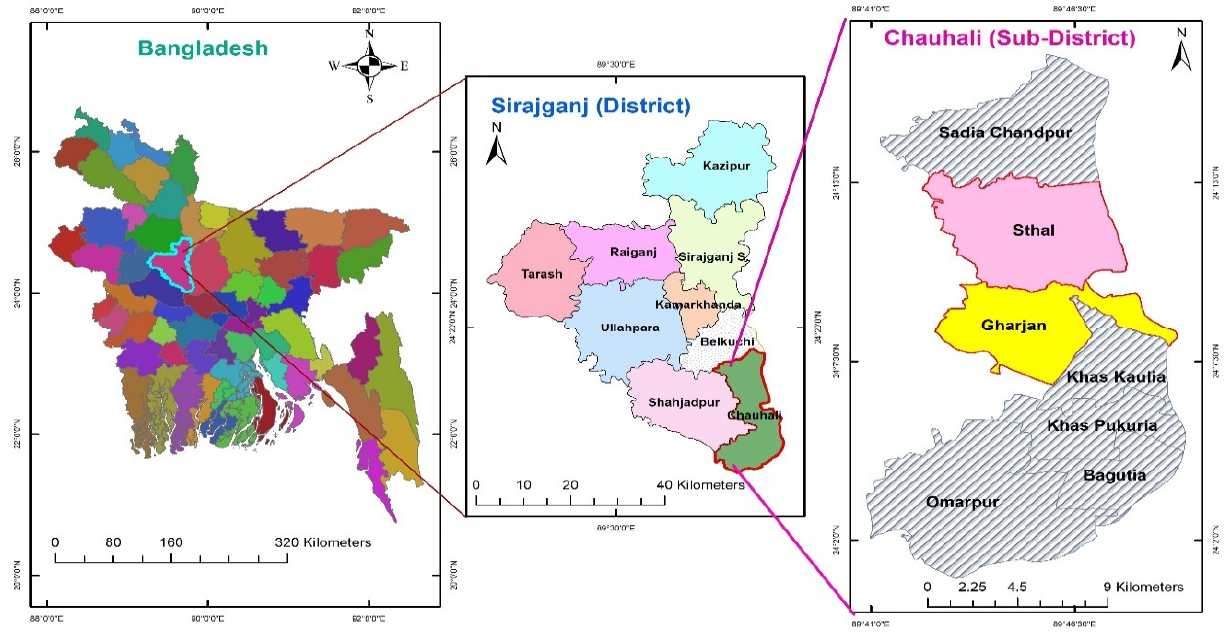
Figure 2. Map of surveyed location. Source: Faruk and Maharjan [46] .